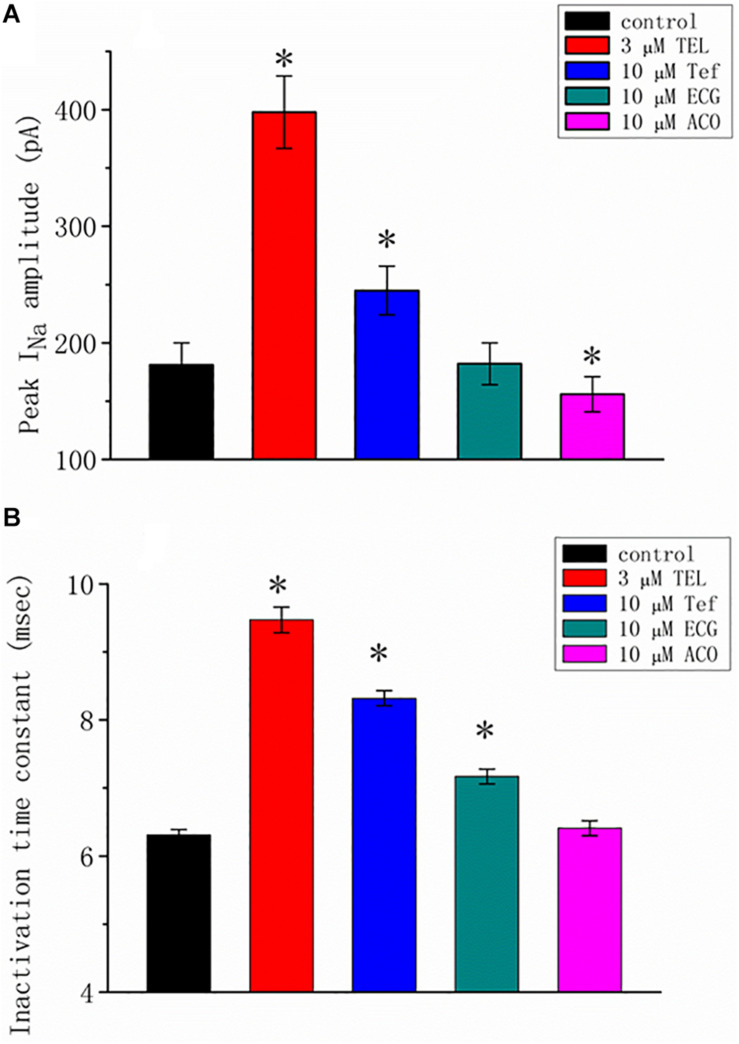
Summary of the data showing the effects of telmisartan (TEL), tefluthrin (Tef), (-)-epicatechin-3-gallate (ECG), and aconitine (ACO) on the (A) peak amplitude and (B) inactivation time constant of INa evoked by a brief depolarizing pulse ranging from −80 to −10 mV (mean SEM; n = 12–15 for each bar). The trajectories in INa inactivation in the presence of the various tested compounds were adequately fit using a single exponential process, while those in the control were fit using a two-exponential process. The value in the control represents the slow component of current inactivation. ∗Significantly different from control (p < 0.05).